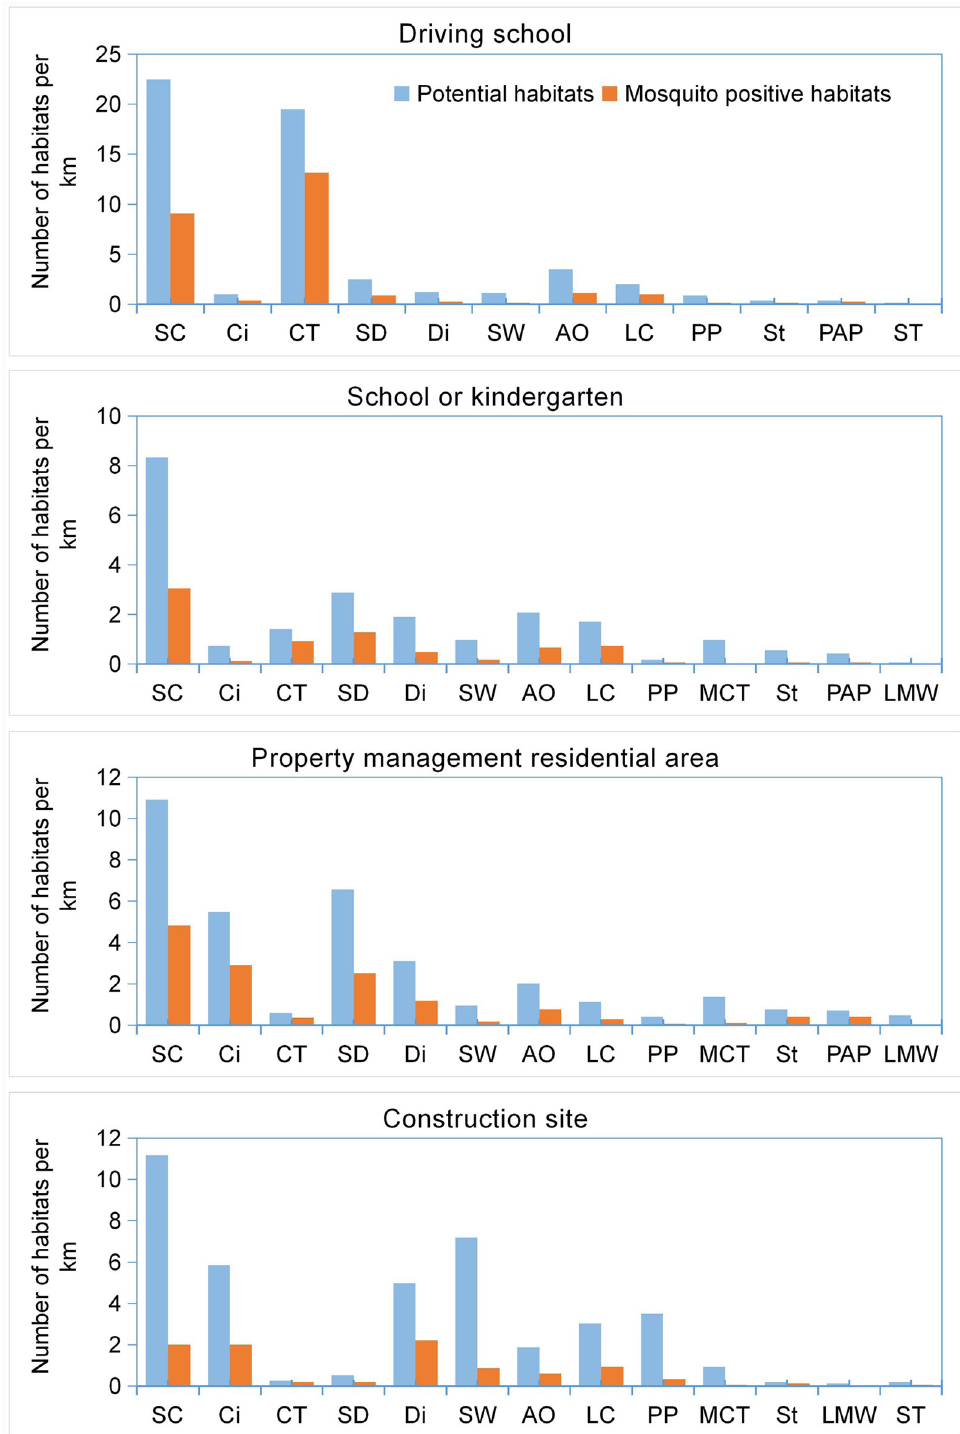
Fig 2. Number of potential habitats and mosquito-positive habitats per km of inspection route by habitat type in built-up areas of Wuhan. That SC, Ci, CT, SD, Di, SW, AO, LC, PP, MCT, St, PAP, LMW and ST were represented by small container, cistern, car tire, storm drain, ditch, shallow water, artificial object, large container, pit or puddle, manhole or cable trench, stump, potted (or aquatic) plant, large and medium water, septic tank, respectively.